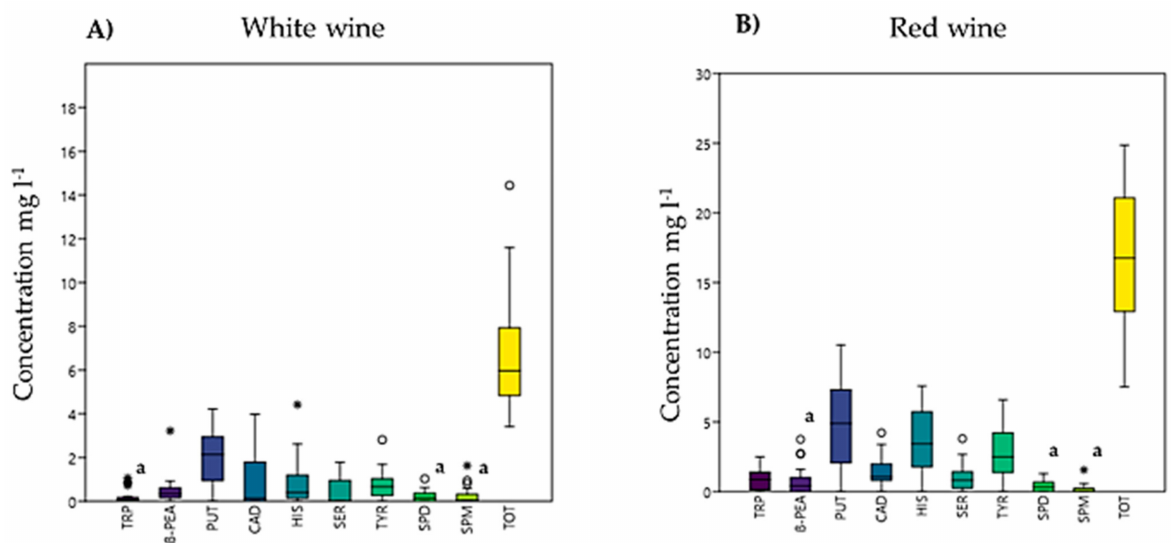
Figure 3. BoxPlot of Biogenic amines amount in white ( A ) and red ( B ) wine. Values are the mean sum of all samples. Bars indicate the minimum and maximum values of the BA amount. Mean values with the same letters are not significantly different according to the ANOVA test ( p <